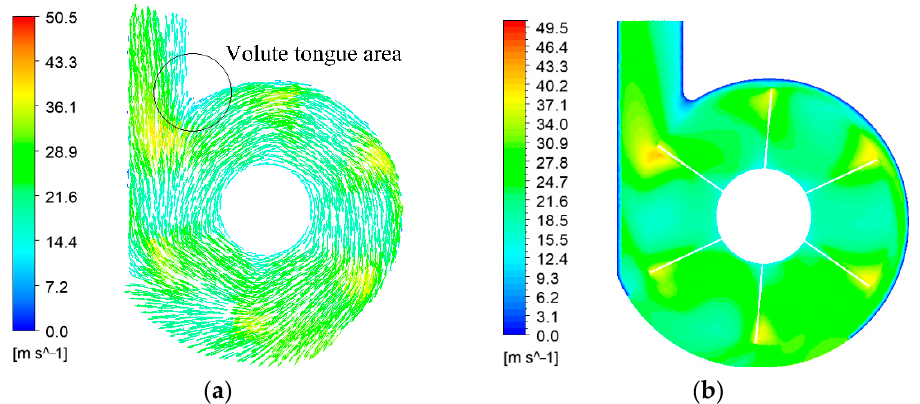
Figure 11. Velocity vector diagram of cross section 1 ( a ) and velocity nephogram of cross section 1 ( b ).